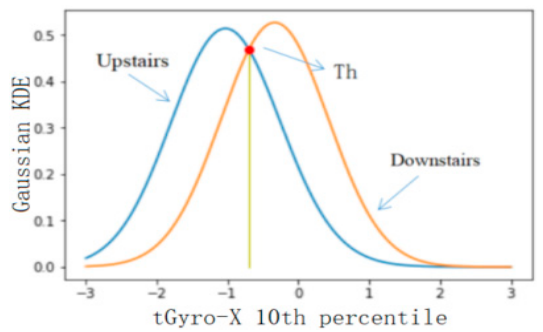
Figure 8. Probability distribution of upstairs and downstairs.